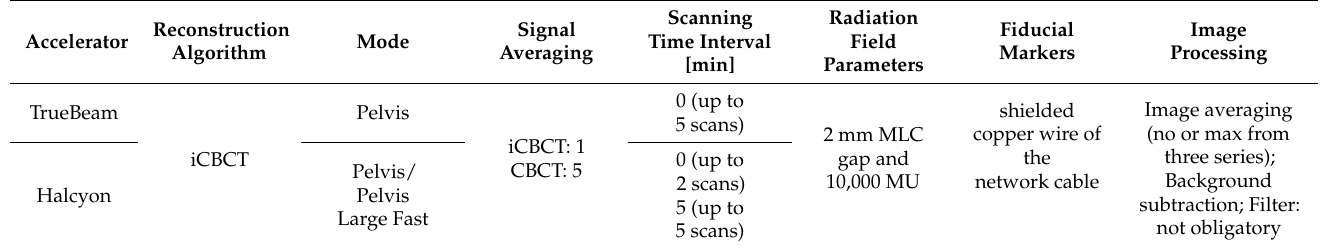
Table 8. Optimal procedures and parameters for determining the irradiation isocenter using PABIG nx 3D dosimeter, Halcyon and TrueBeam accelerators and polyGeVero-CT data